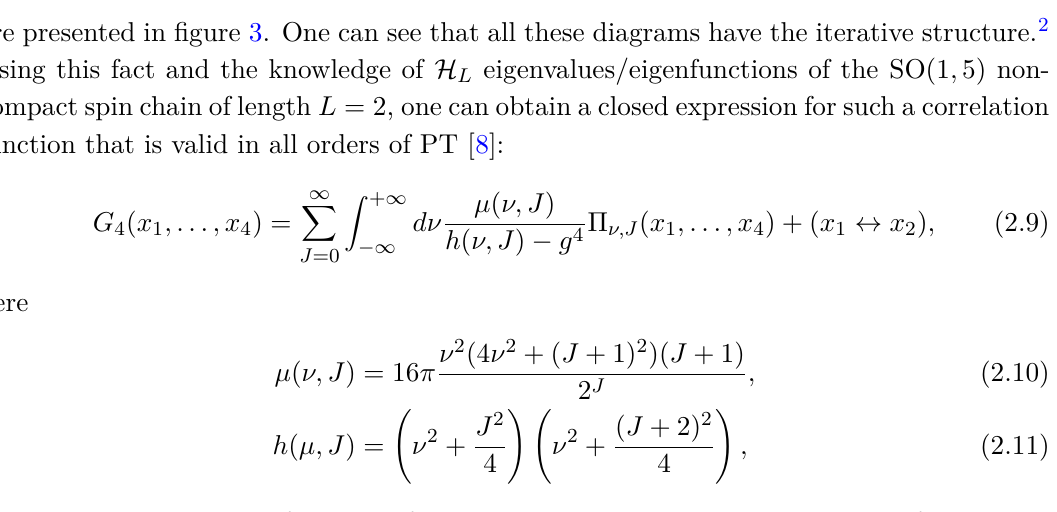
( x ) φ ( x )) tr ( φ ∗ ( x ) φ ∗ ( x )) i in the D = 4 , ω = 1 fishnet 1 1 1 2 3 4 1 1 1 ↔ x 2